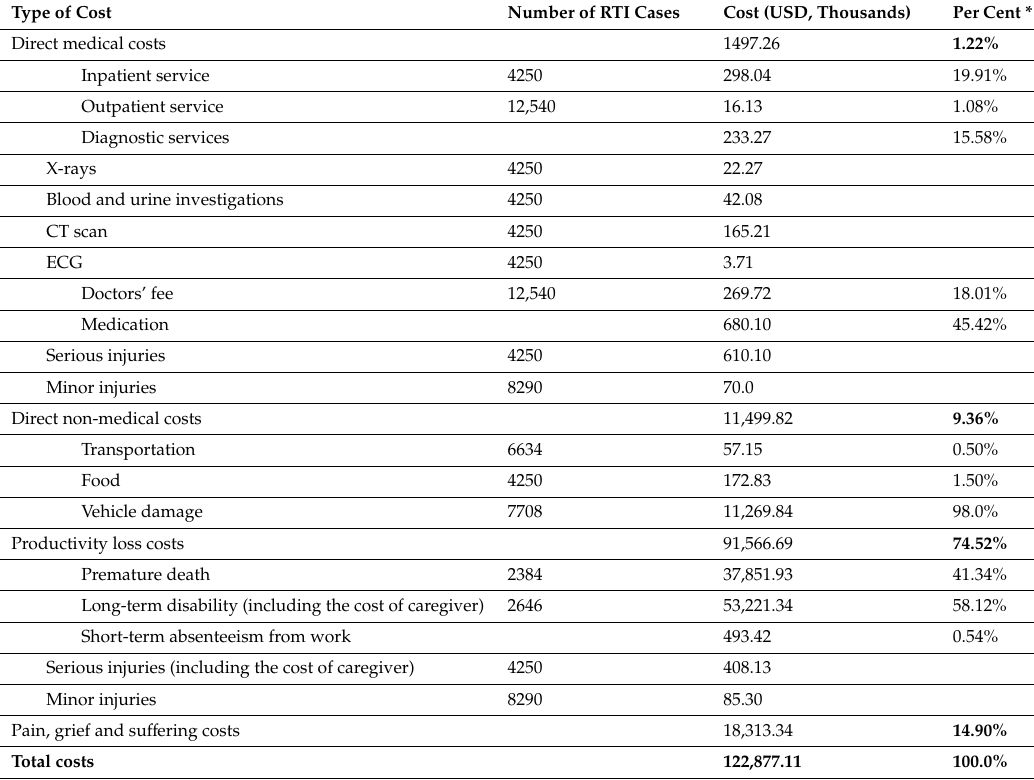
Table 4. Total economic burden of road tra ffi c injuries (RTIs) in Nepal in 2017.